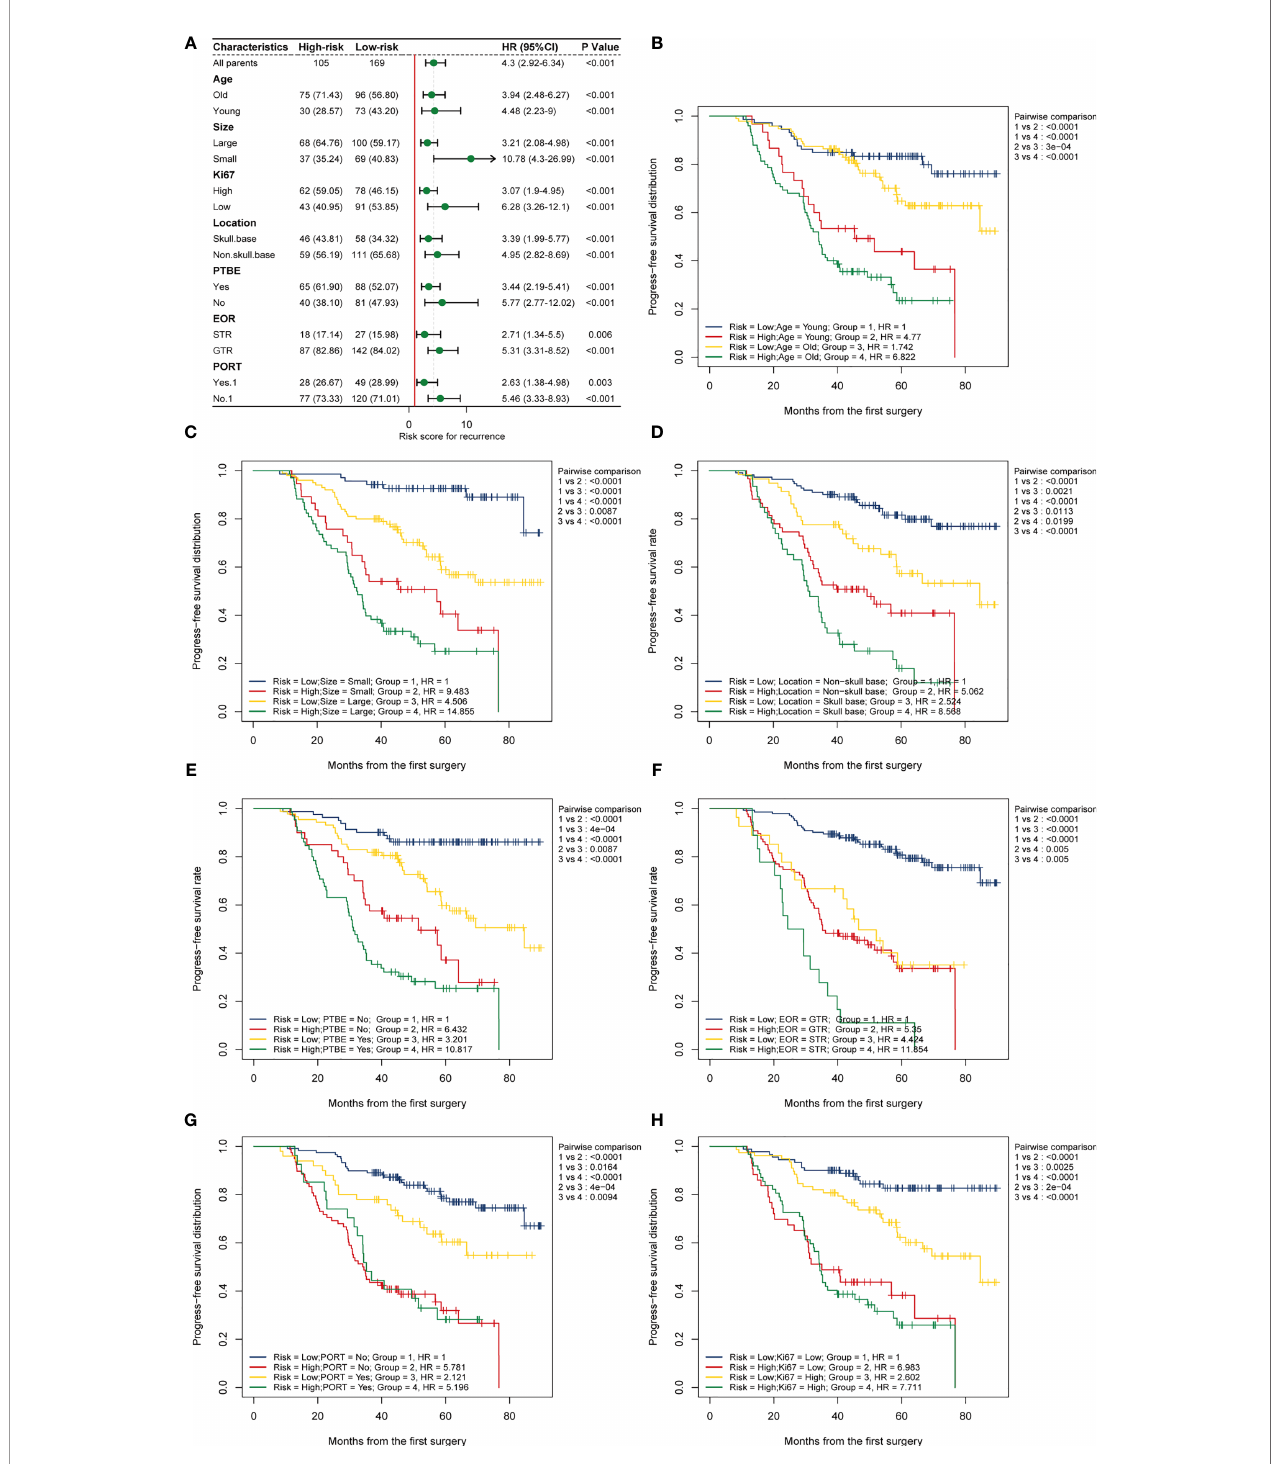
FIGURE 5 | Subgroup analysis. (A) Subgroup analysis forest map shows the prognostic value of the hematological risk model in different subgroups categorized by age, location, tumor size, PTBE, EOR, Ki-67, and PORT. A high risk score is an independent risk factor for meningioma progression in different subgroups. (B – H) Two-factors Kaplan-Meier curves of progress-free survival for patients with AM categorized by risk scores and other clinical factors: (B) age; (C) size; (D) tumor location; (E) PTBE, peritumoral brain edema; (F) EOR, extent of resection; STR, subtotal resection; GTR, gross total resection; (G) PORT, postoperative radiotherapy; (H) Ki-67